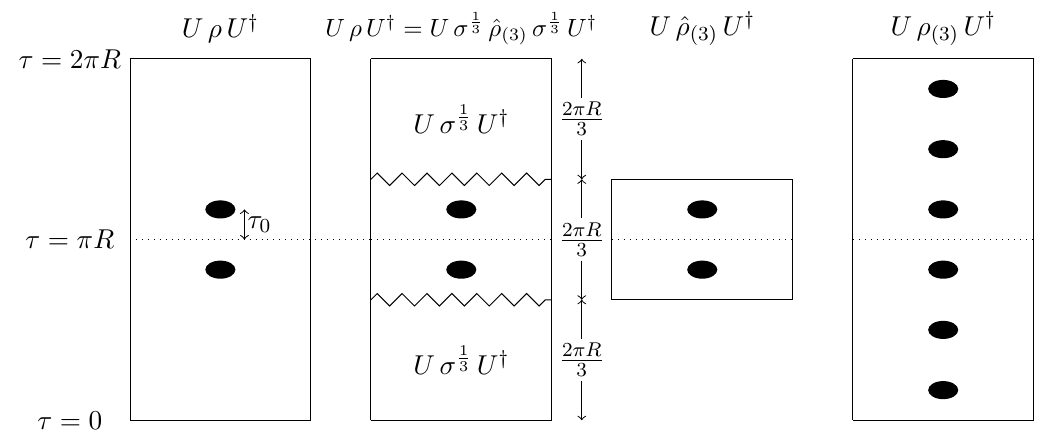
using a Euclidean ( n )